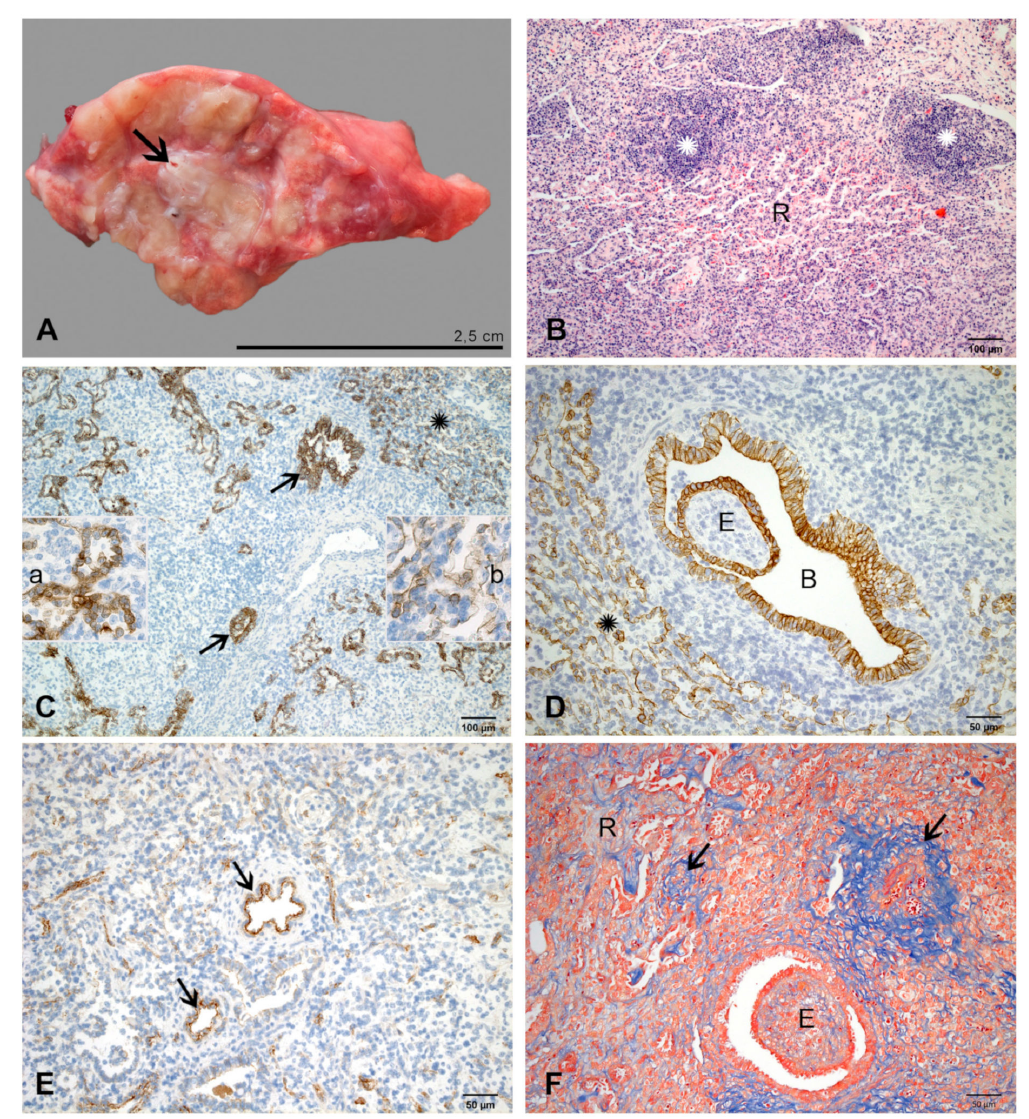
Figure 7. Pulmonary lesions at 14 dpi. ( A ) Section through a middle lobe. The small lesions (white) are centered around a bronchus (arrow) and not well demarcated. ( B ) Extensive regeneration (R) of pulmonary tissue with thick interalveolar septa and narrow alveolar spaces; multifocal organized lymphoid tissue (stars) in the interlobular septum. HE-stain. ( C ) Cuboidal epithelial cells (brown) form irregular alveolar spaces; an area with more progressed regeneration is indicated (star). Bronchiolitis obliterans is seen in most airways (arrows). Inset a: higher magnification of cuboidal epithelial cells forming alveolar spaces. Inset b: higher magnification of delicate, elongated epithelial cells in the area with progressed regeneration. IHC, cytokeratin. ( D ) Higher magnification of more regular alveolar structures lined by type 2 alveolar epithelial cells (star) and the exudate (E) within a bronchiolus (B) lined by cuboidal epithelial cells. IHC, cytokeratin. ( E ) Factor VIII labels endothelial cells in blood vessels (arrows, examples). There is no exudation of fibrin into and through vascular walls. IHC, factor VIII. ( F ) Fibrinous exudate within and around arteriolar walls (arrows) is replaced by collagen fibers (blue). Increased collagen is present in interalveolar septa in the area of regeneration (R) and in the exudate (E) organized by bronchiolitis obliterans. Azan